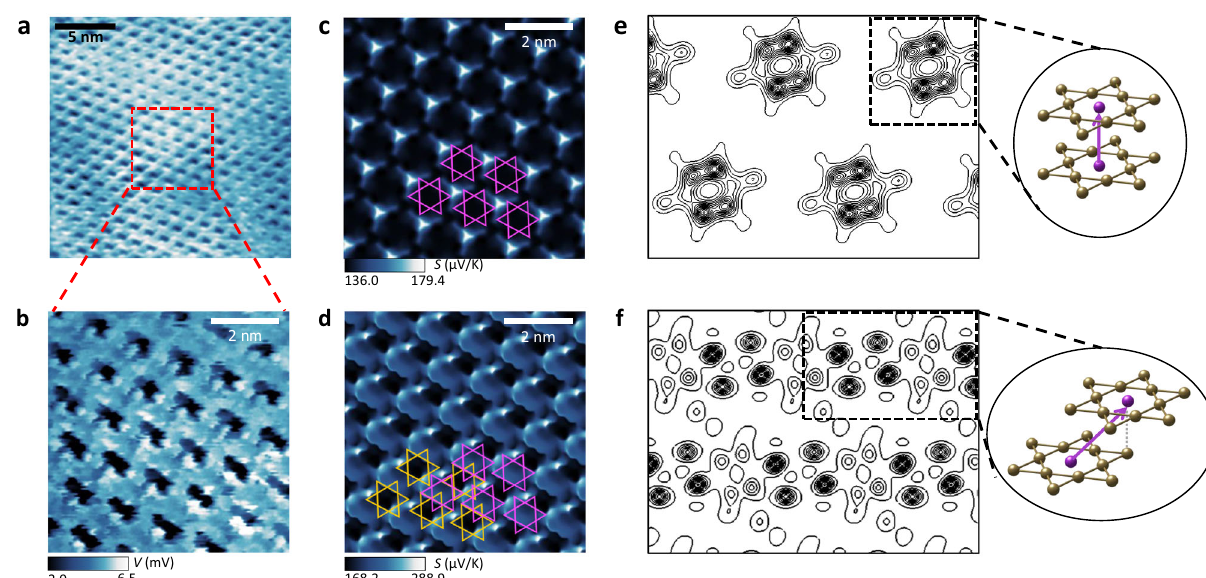
c , d Theoretical scanning Seebeck pro fi les of A stacking c and L stacking d bilayer commensurate CDW phase in 1T-TaS 2 . The magenta and orange SoD in d denote thetopandbottomlayerCDW,respectively. e , f Thevalenceelectrondensitiesof A stacking e and L stacking f bilayer in the middle of the two layers are shown with their atomic con fi guration for stacking. Only Ta atoms are displayed for